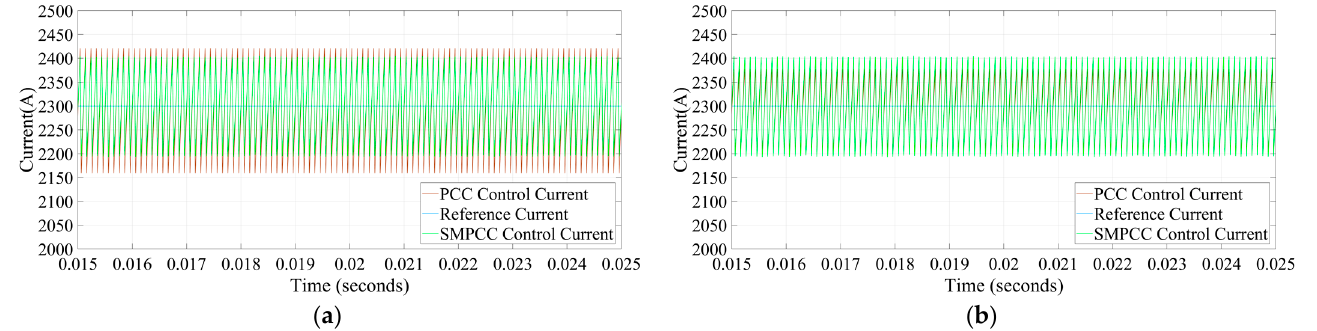
Figure 10. When the real parasitic resistance value is different from the control value. ( a ) Comparison of ∆ L = − 0.2 L and ∆ L = 0; ( b ) Comparison of ∆ L = 0.2 L and ∆ L = 0.